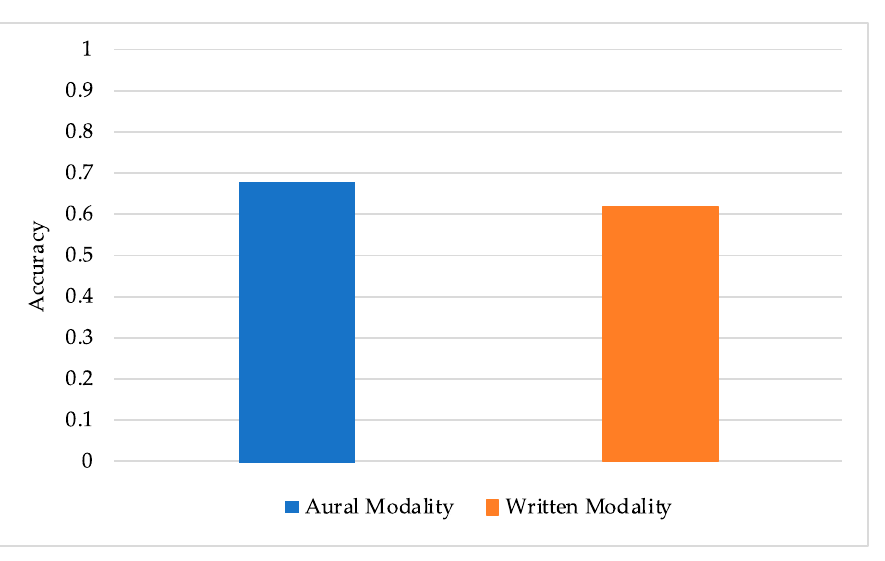
Figure 9. Number of Spanish courses completed by the HL learners. The HL learners’ model for modality effects in the comprehension of passives included the dependent variable accuracy (binary outcome 1 or 0) analyzed as a function of condition (type of passive), modality, and instruction as fixed effects, with random intercepts for subjects and items, and by-subject and by-item random slopes for condition. Modality was coded using contrast coding,